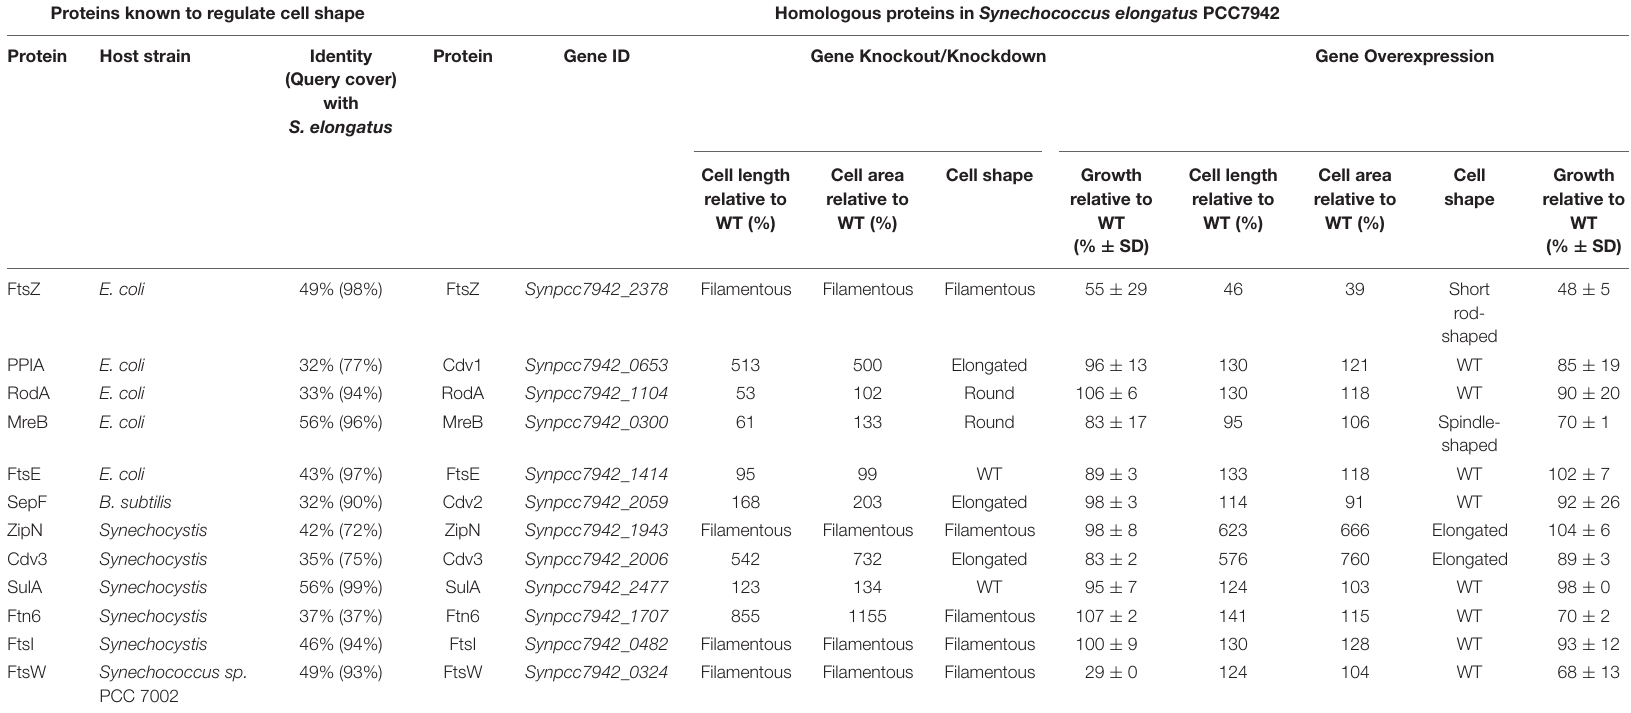
TABLE 1 | Selection and engineering of candidate genes potentially participating in cell morphogenesis in Synechococcus elongatus PCC7942. Proteins known to regulate cell